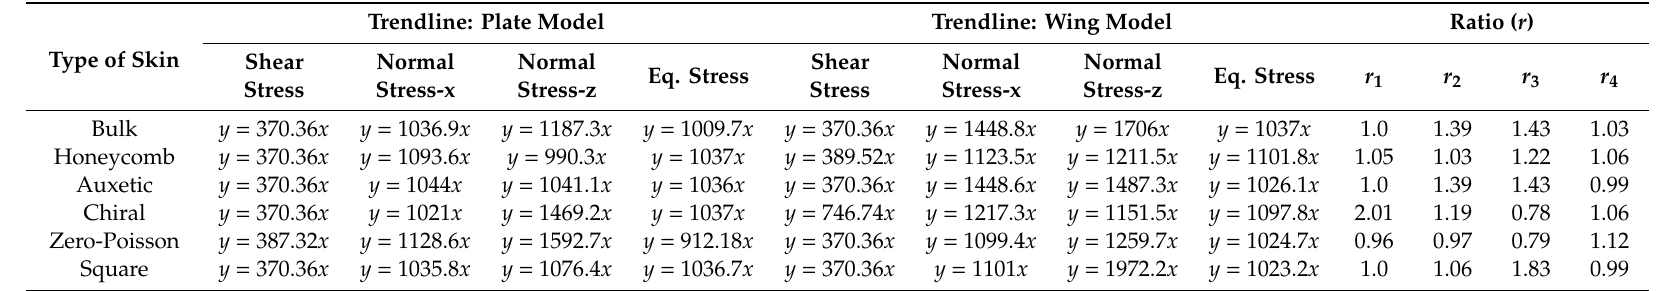
Table 5. Relation between 3D wing model and 2D plate